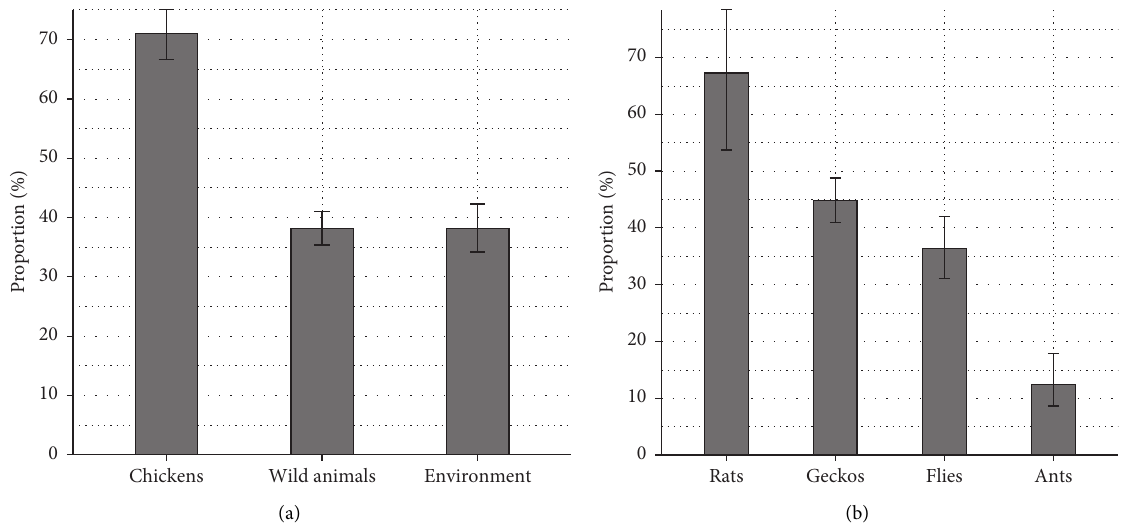
Figure 1: Bar graphs showing the proportion of E. coli isolated from cloacal swabs of chickens, wild animals, and environment (a) and proportion of E. coli isolated from ants, geckos, flies, and rats (b). The error bar indicates 95% confidence